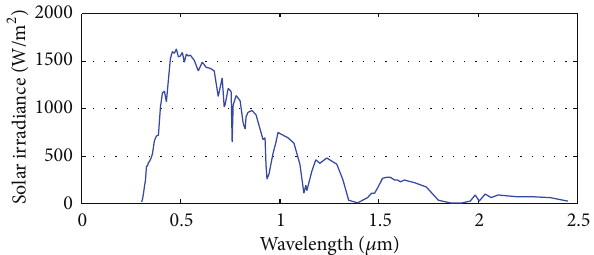
Figure 2: The irradiance distribution characteristic of AM1.5D solar